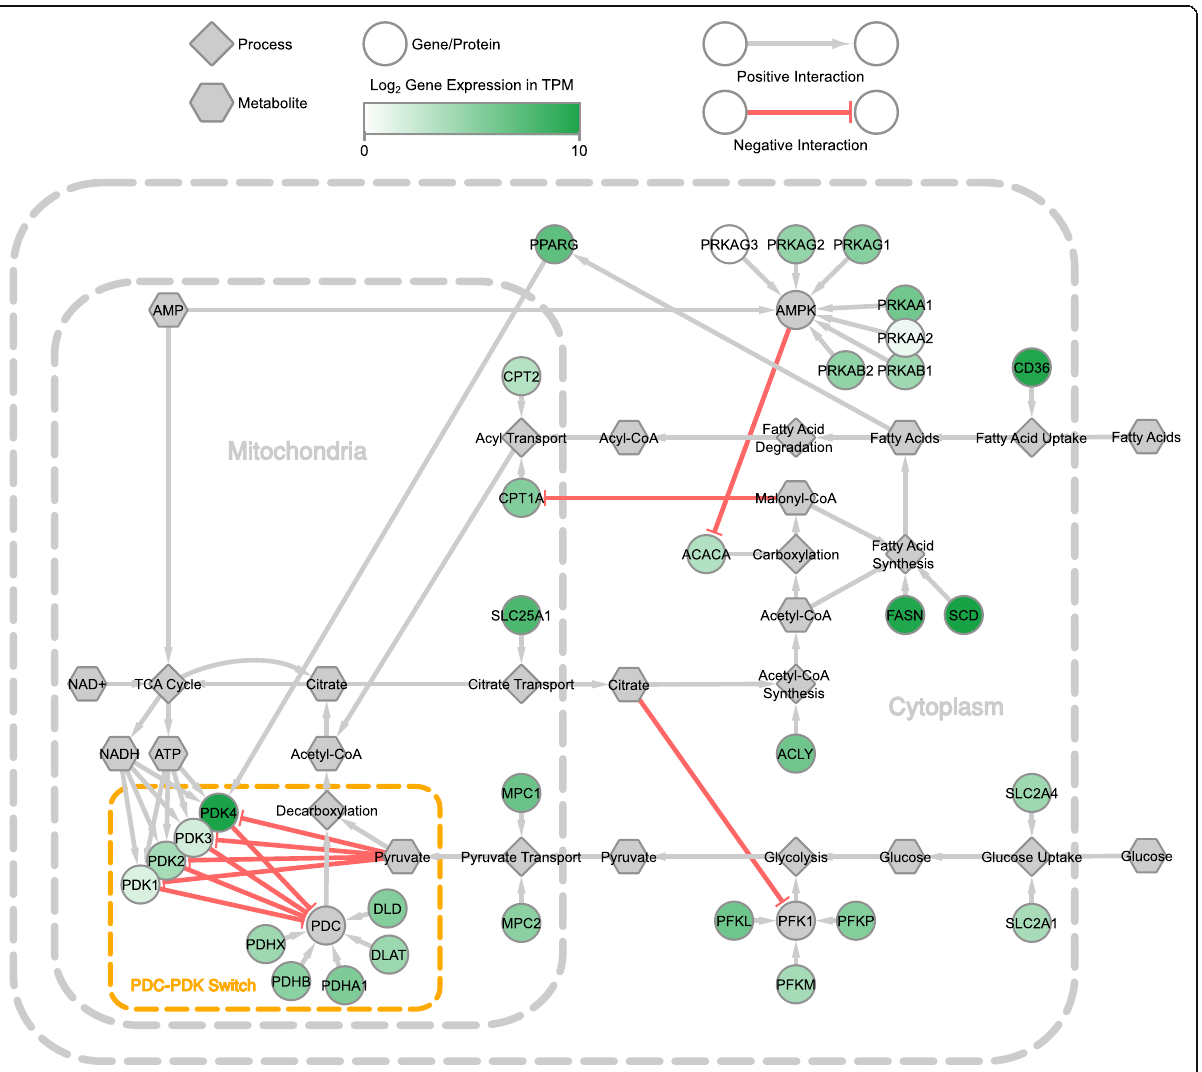
Fig. 3 Baseline gene expression of the network in the adipose tissue. Expression is median log 2 TPM expression of GTEx Homo sapiens baseline dataset from Expression